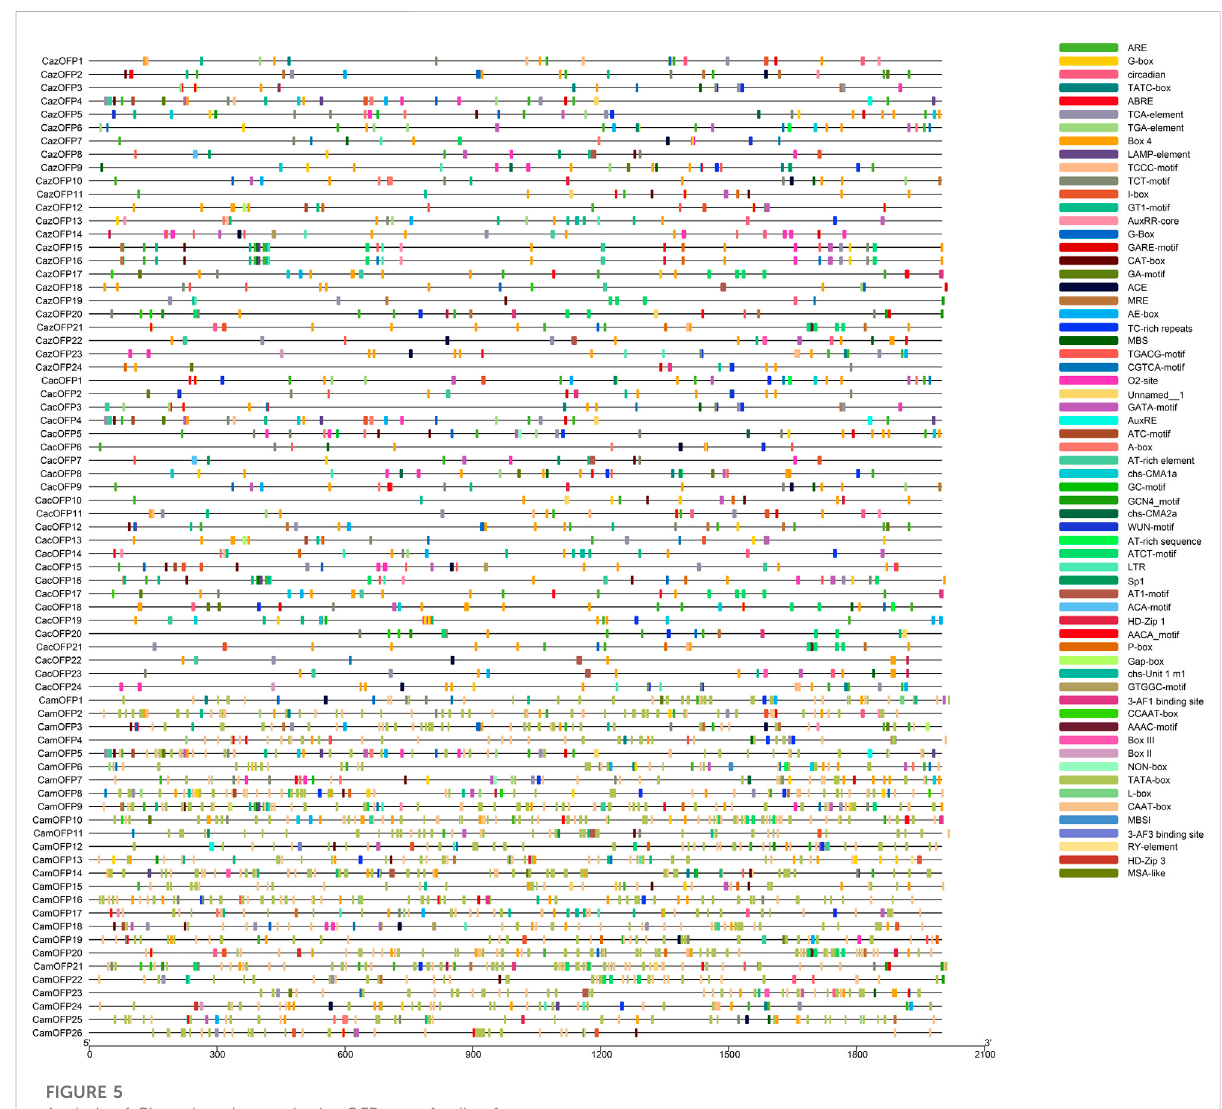
FIGURE 5 Analysis of Cis -acting element in the OFP gene family of